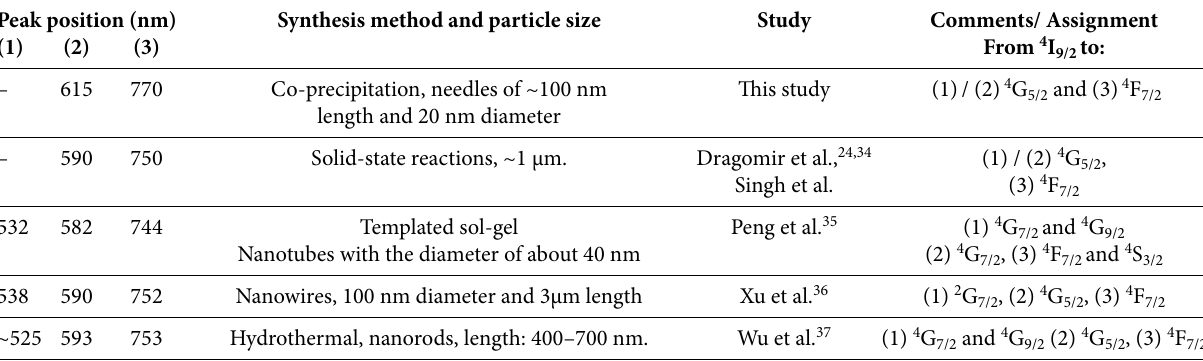
Table 3. Characteristic peaks observed in the 500–800 nm range in the UV-Vis absorption spectra of NdVO 4 .